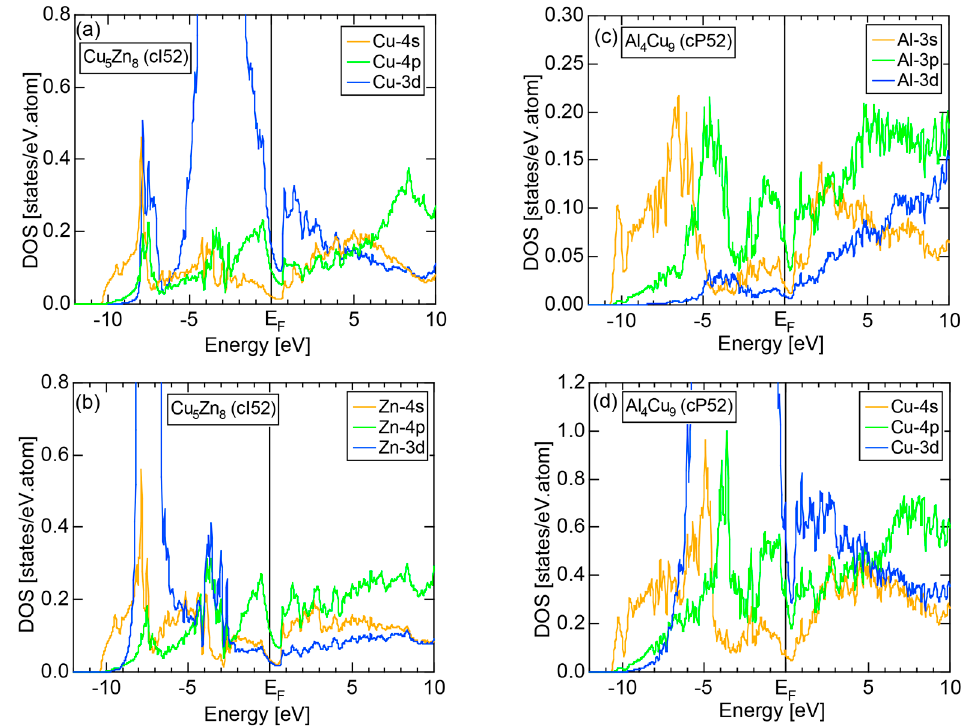
Figure 32. ( a ) Cu- and ( b ) Zn-pDOSs for Cu 5 Zn 8 (cI52) and ( c ) Al- and ( d ) Cu-pDOSs for Al 4 Cu 9 (cP52).